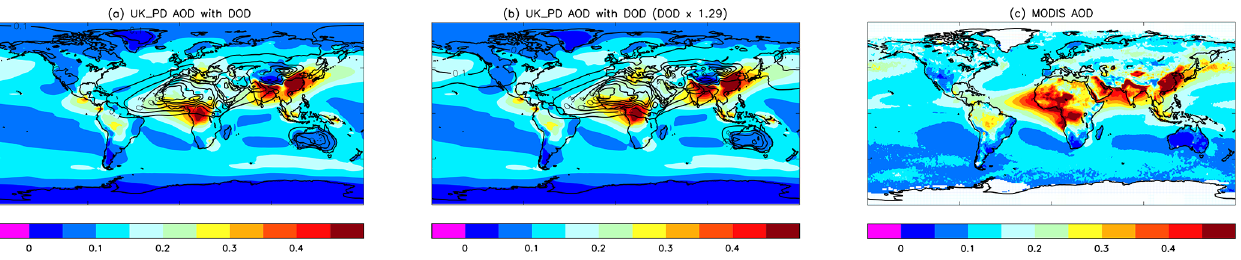
Figure 5. AOD (550nm) from (a) UK_PD, with contours showing the fractional contribution of dust to total AOD. (b) Same as panel (a) but with dust optical depth multiplied by 1.29. (c) MODIS 2003–2012